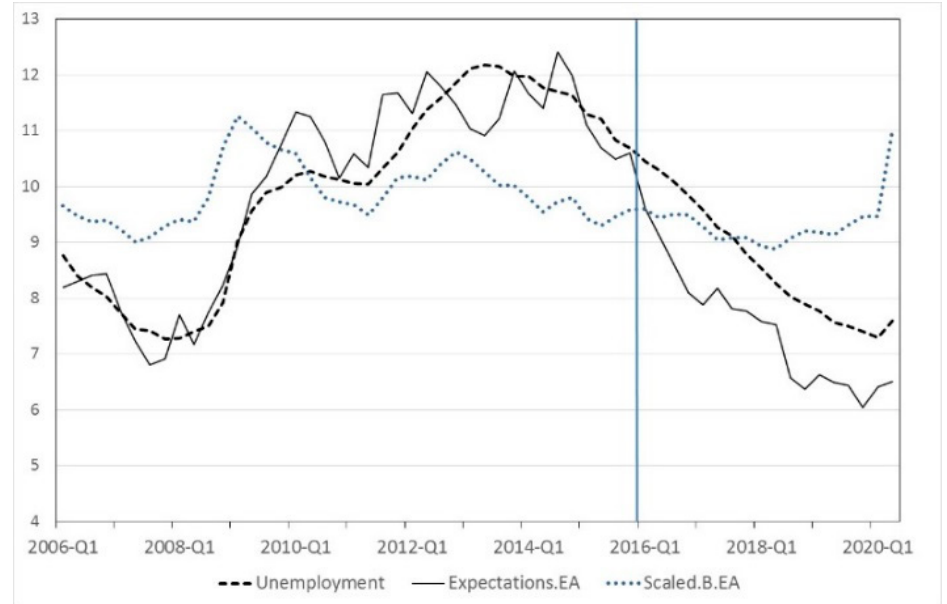
Figure 3. Evolution of unemployment expectations in the euro area (EA).